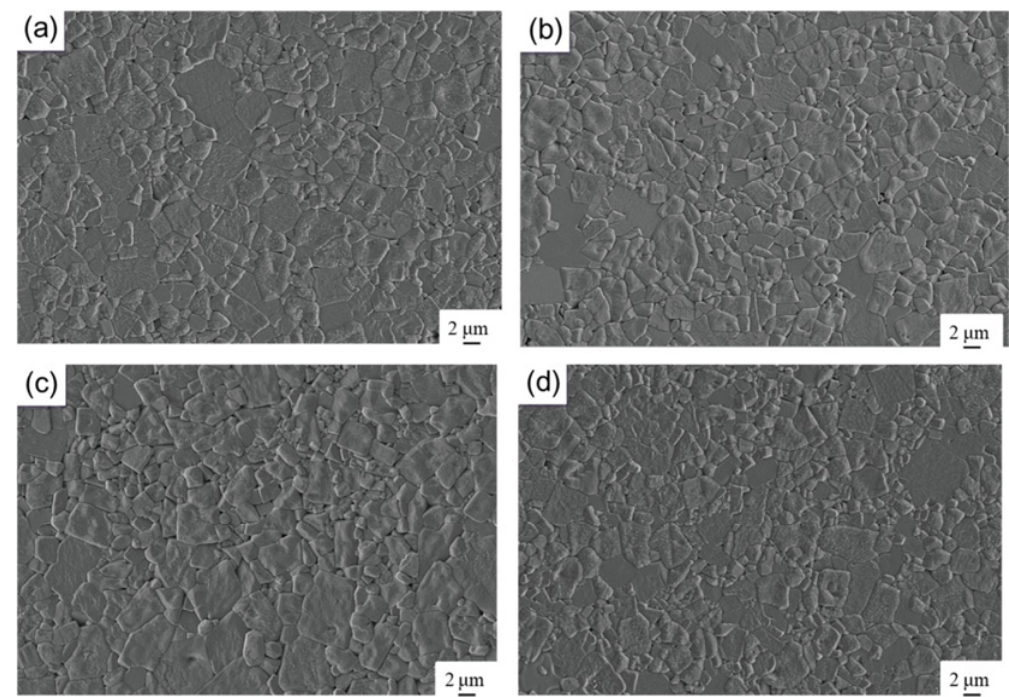
Fig. 1 SEM images of thermally etched surfaces of LKNNS  EuNZ  x BZ samples: (a) x = 0.01, (b) x = 0.02, (c) x = 0.03, and (d) x